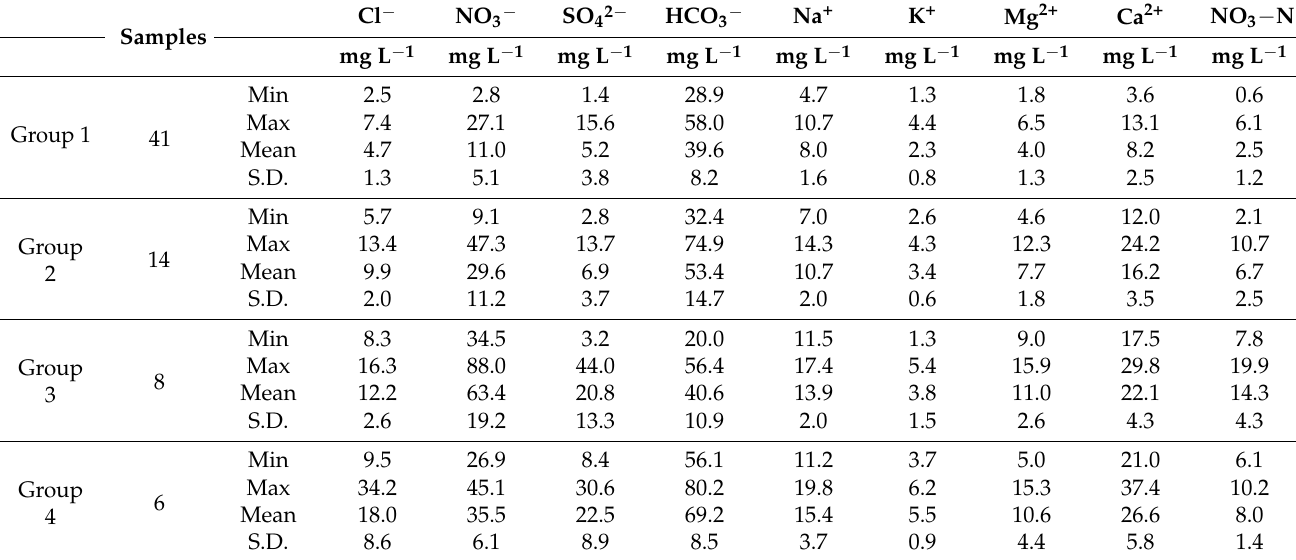
Table 3. Dissolved ion concentration depending on pollution